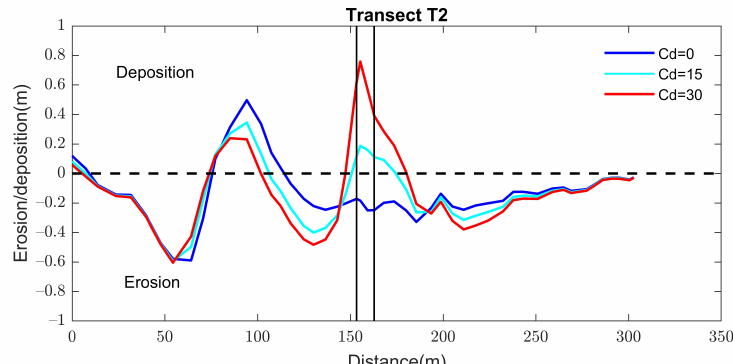
Figure 12. Erosion/sedimentation at the transect T2 with different drag